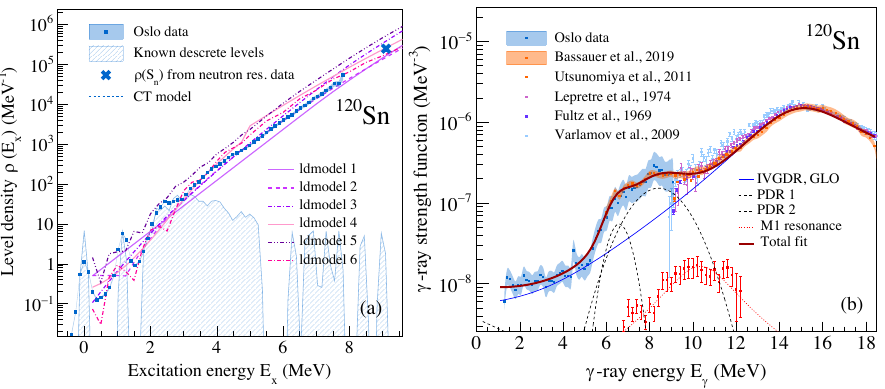
Figure 1. (a) The experimental NLD of 120 Sn shown with the discrete states from [8] and the theoretical NLD models available in TALYS. (b) The experimental GSF of 120 Sn shown together with the E 1 and M 1 strengths from Ref. [4] and ( γ, n ) experiments from Refs. [9–12]